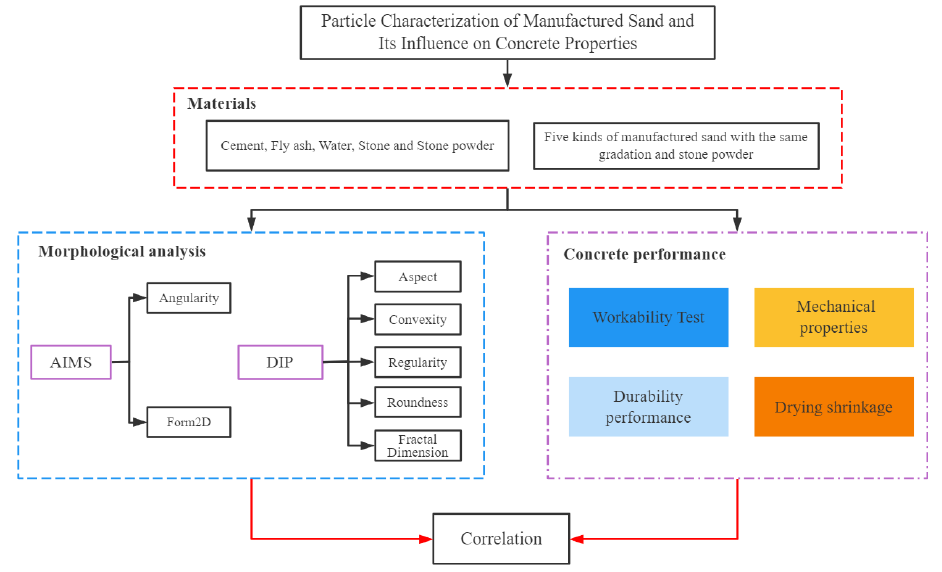
Figure 1. Technical route of this